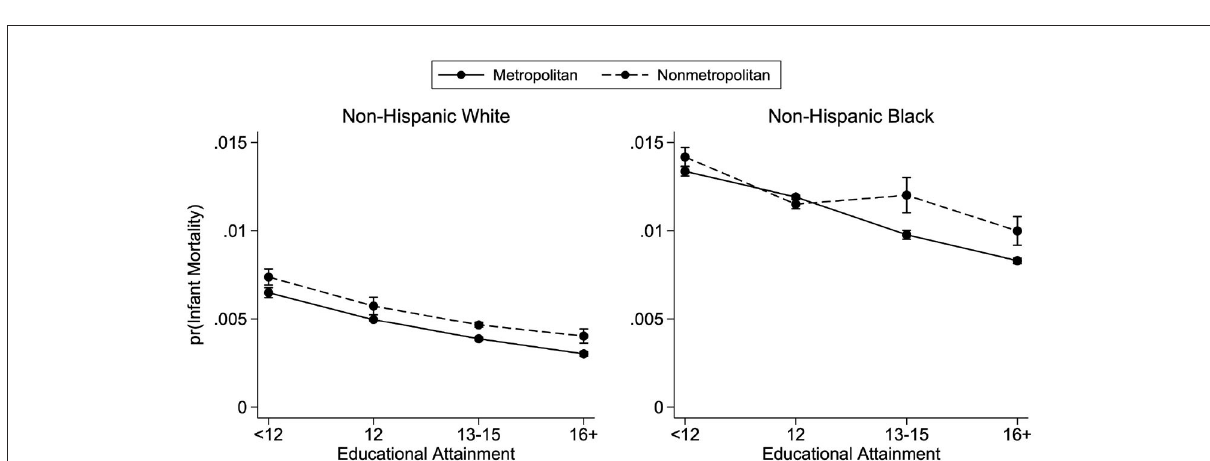
FIGURE8 Predicted probabilities of infant mortality by metropolitan residence and race, 1998–2002, state subsample. Educational gradients of infant mortality by race and metropolitan residence for states that had adopted the 2003 revised birth certificate form before 2011. Births occurred between 1998 and 2002. Supplementary Table 6 has full regression results from which the predicted probabilities are calculated. See Figure 5 for complete figure notes and Figure 6 for states included in